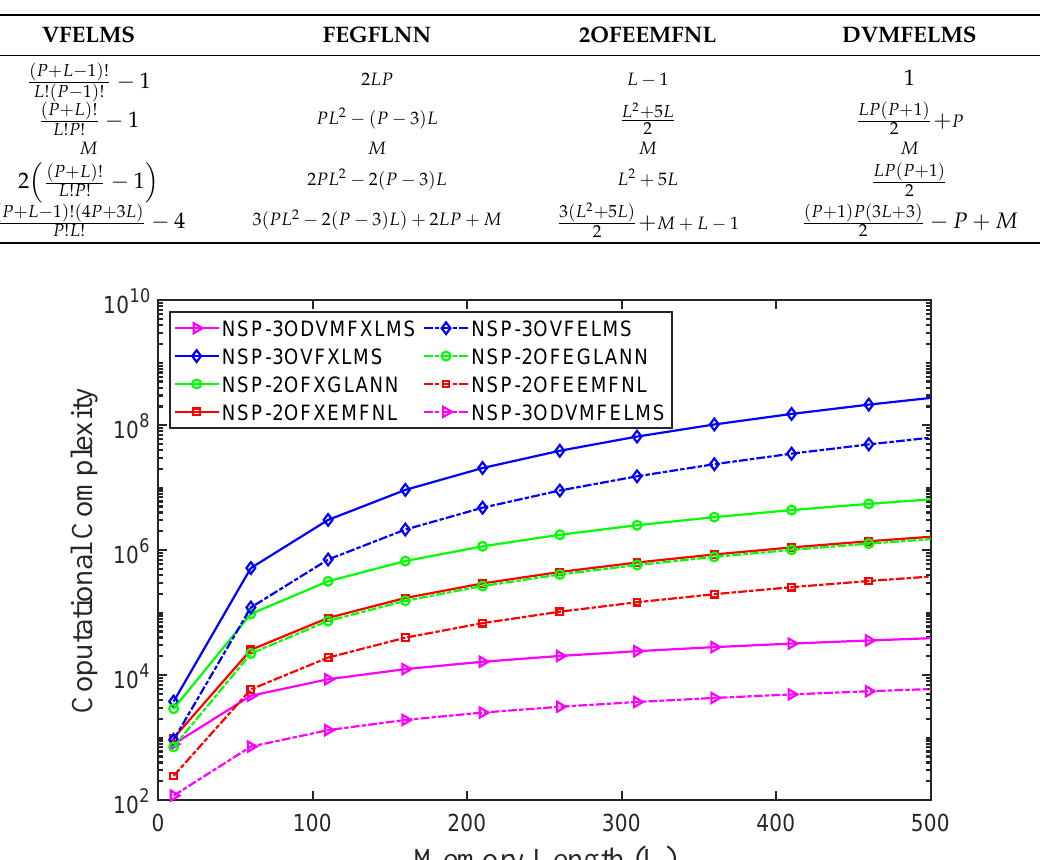
Table 2. Computational complexity of different algorithms for NANC with the NSP using filtered-error structure.